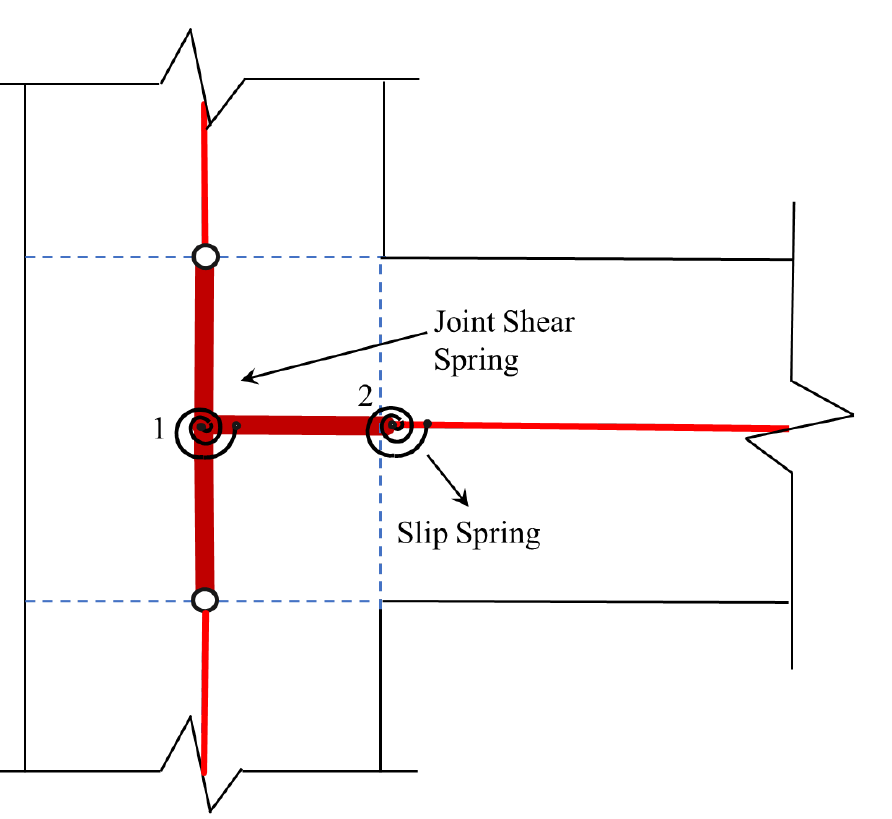
Figure 15. Modified scissor model with two rotational springs in series to demonstrate panel and interface shear failure, reproduced from literature [7].